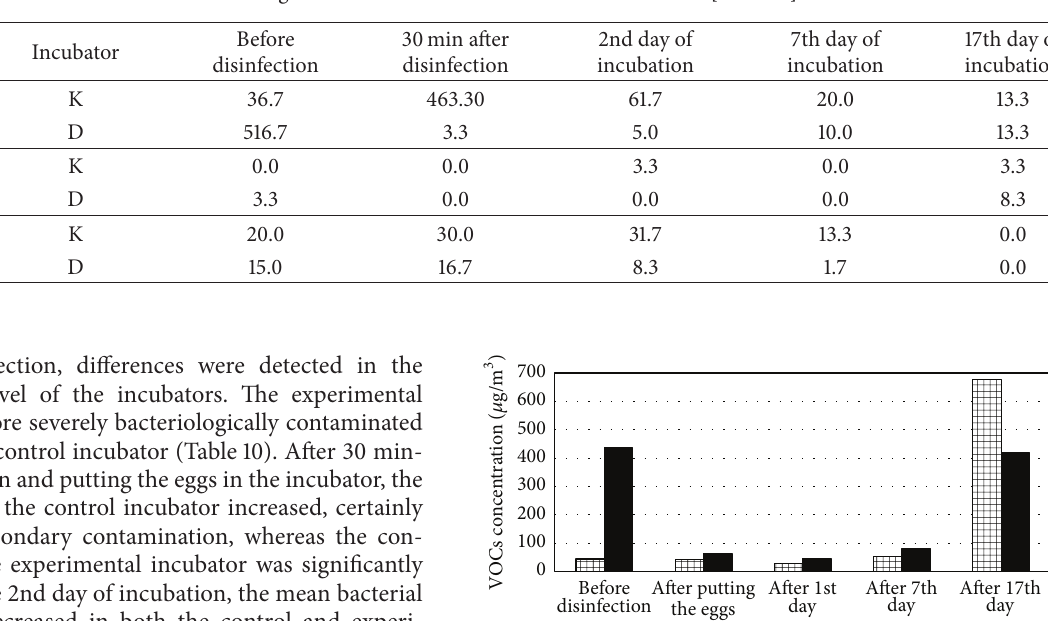
Table 10: Microbiological contamination on the walls of the hatchers [cfu/cm 2 ].